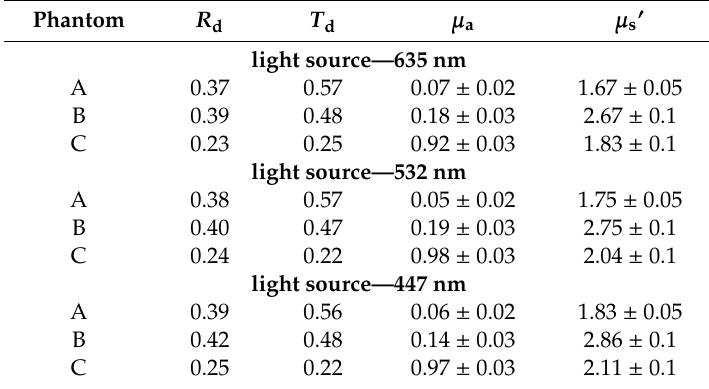
Table 1. Obtained measurement results of phantoms A, B and